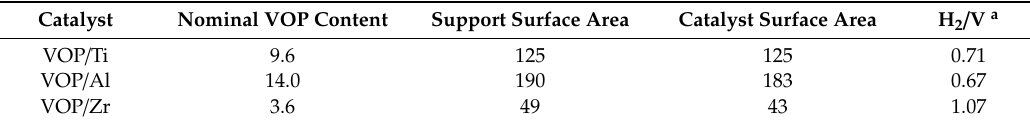
Table 1. Nominal vanadyl orthophosphate (VOP) content (wt. %), surface area (m 2 · g − 1 ) of supports and catalysts, and H 2 / V as calculated by the temperature-programmed reduction in hydrogen (H 2 -TPR).